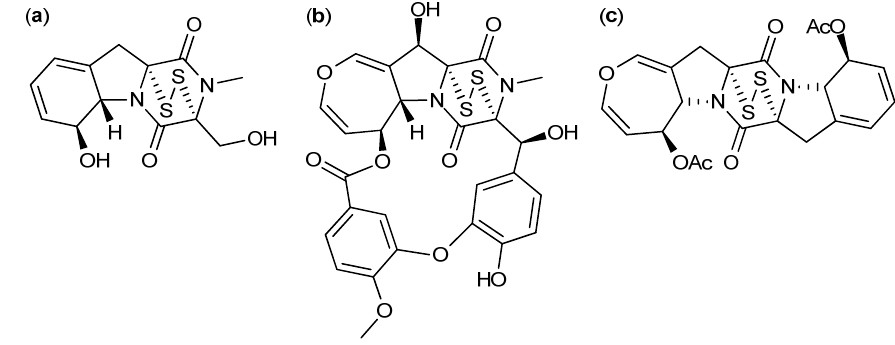
Figure 15. Diketopiperazines with a di-sulfide bridge: ( a ) Gliotoxin, ( b ) Emestrin A and ( c )